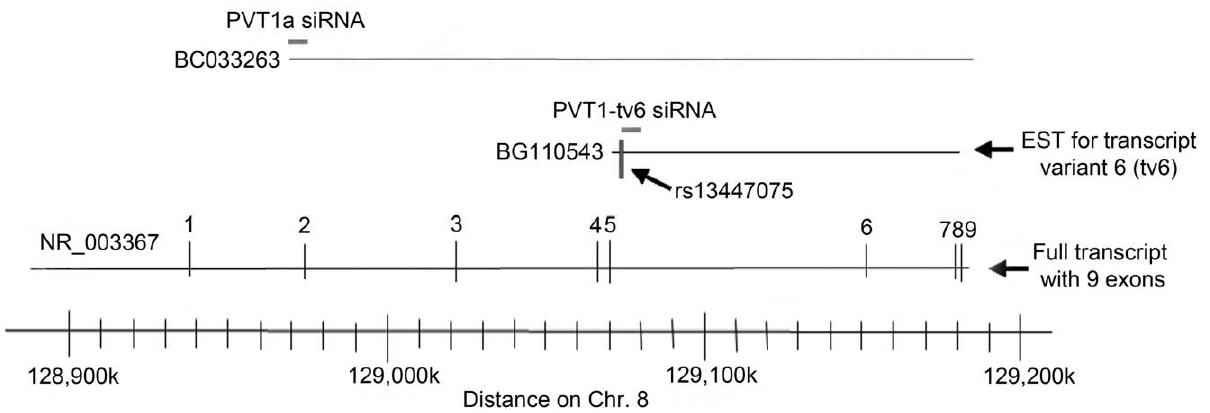
Figure 6. Position of the two PVT1 siRNAs, PVT1a and PVT1-tv6, used for transfection of mesangial cells. The SNP with the highest association with ESRD in type 1 diabetes, rs13447075, is shown as a vertical line next to the PVT1-tv6 siRNA. Bottom, chromosome distance coordinates in kb from National Center for Biotechnology Information Build 37.1 of the PVT1 locus.